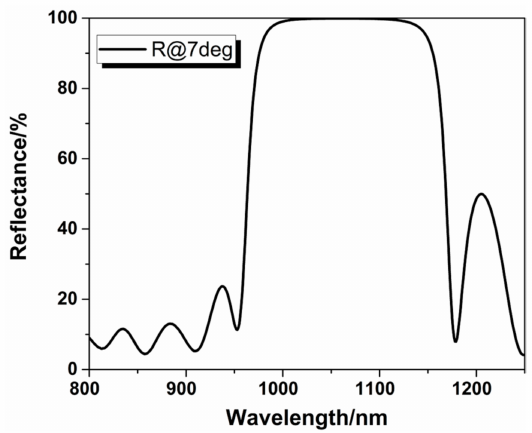
Figure 8. The experimental reflectance spectrum of the 1064-nm Hf 0.70 Si 0.30 O 2 /SiO 2 high reflec- tive coating.